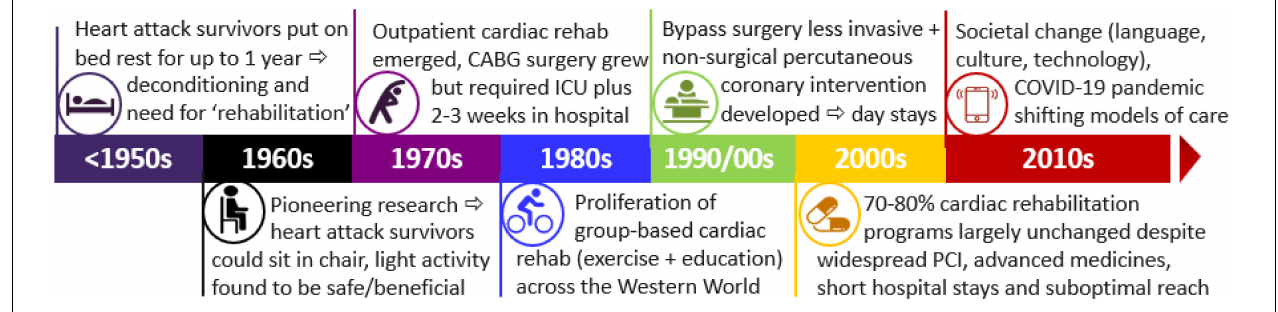
BOX 1 | Quotes from an interview about the emergence of cardiac rehabilitation in the 1970s with Sister Doreen Hennesy who was “Sister-in-Charge” of a Coronary Care Unit in Sydney, Australia (26). “In 1972 when I became the Sister-in-Charge of the Coronary Care Unit at Parramatta, cardiac monitoring and this type of thing was very new and exciting and we so conquered the cardiac arrest situation ... . So a lot more patients were living that would have died. However, they weren’t living. They were wrapped in cotton wool, they were scared, they were terrified. So I started an education program of the patient while they were in hospital, explaining what the heart attack was to them in lay terms.” “I started early ambulation in 1975 where we were getting patients out of bed within 2 days of their admission. This was unheard of.” “In 1978 we exercised the first patient, ten days after an ‘infa’ (infarction). It was exciting. It was everything that I ever wished to do. It was also very frightening. Although, I had seen it all working in Canada and knew it was safe, the first patient was exercised in front of doctors from the Heart Foundation, the medical directors and physicians from Parramatta Hospital and I was just there with one bike and a little machine.” “Within two months, I had about forty patients and I was just one staff. Then it grew and then I got more staff, more patients. At some stage we had 65 patients a day, just in a session in the evening where we used run the cardiac gymnasium. It was also really a lot of fun; the nursing staff did it in their own time and we used the hospital’s equipment. Sometimes, we had up to 80 patients in an evening, just coming in skipping rope, bench stepping using some of the equipment, calisthenics; all this was done by these cardiac